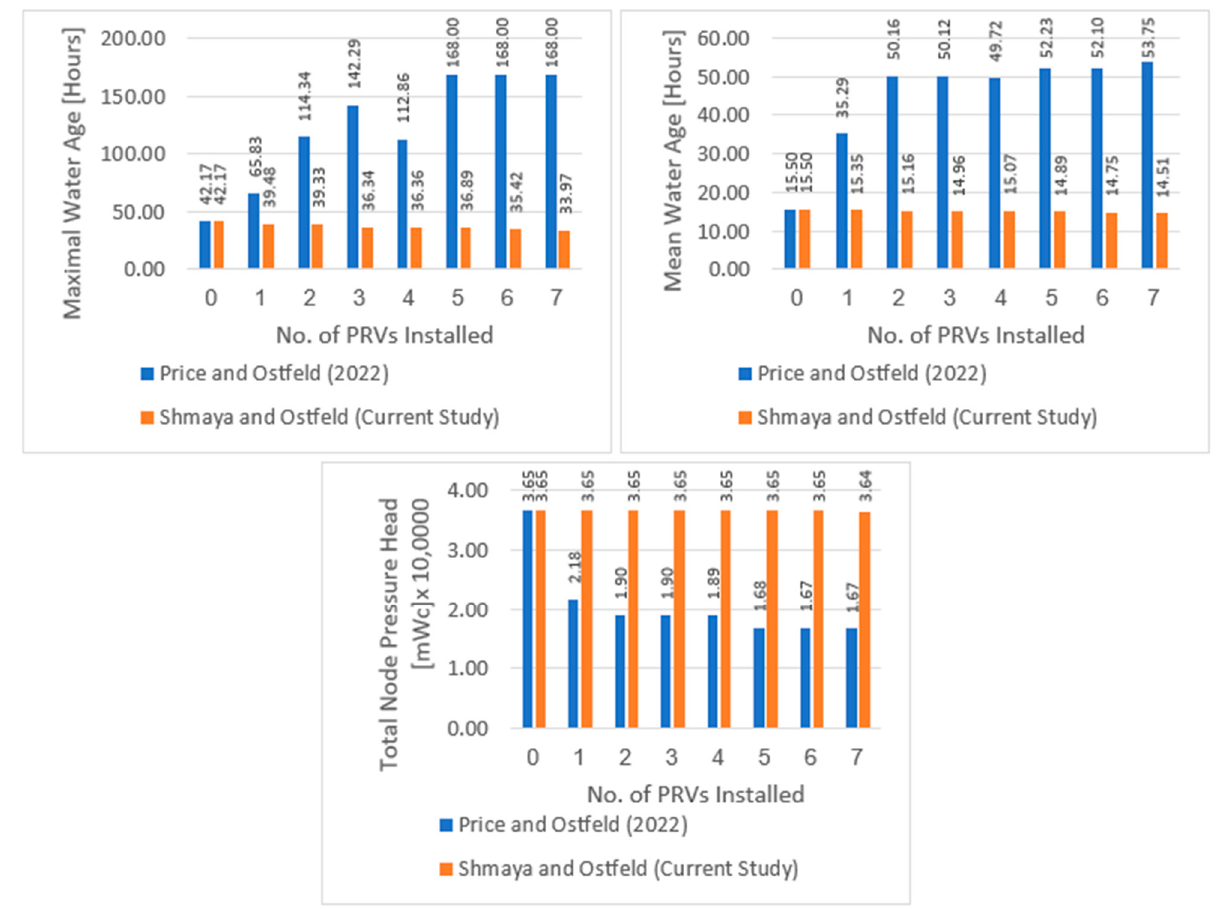
Figure 4. Maximal water age ( top left ), mean water age ( top right ) and total node pressure ( bottom ) after placing each one of the seven PRVs on the synthetic network using both methods.